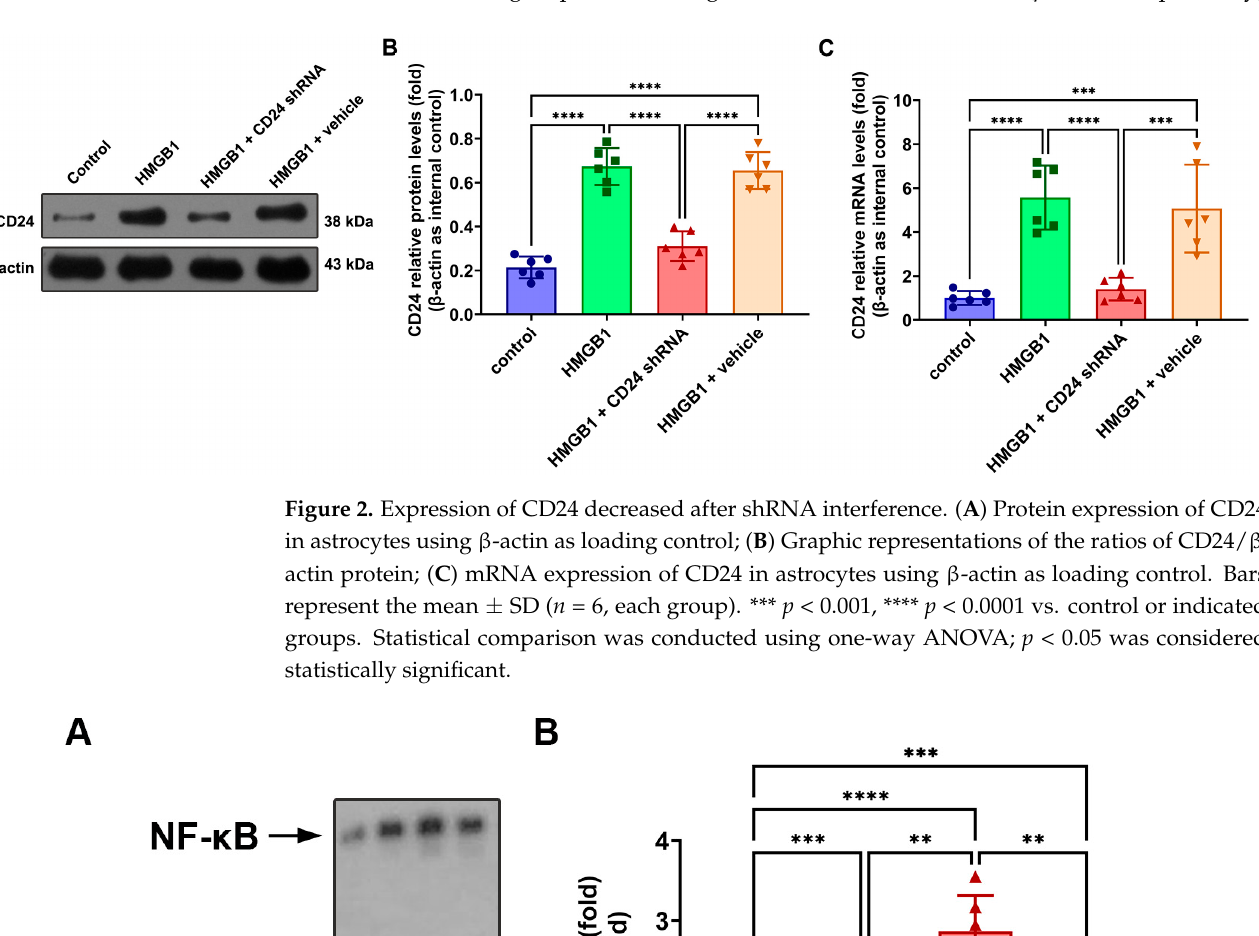
Figure 2. Expression of CD24 decreased after shRNA interference. ( A ) Protein expression of CD24 in astrocytes using β -actin as loading control; ( B ) Graphic representations of the ratios of CD24/ β - actin protein; ( C ) mRNA expression of CD24 in astrocytes using β -actin as loading control. Bars represent the mean ± SD ( n = 6, each group). *** p < 0.001, **** p < 0.0001 vs. control or indicated groups. Statistical comparison was conducted using one-way ANOVA; p < 0.05 was considered sta-